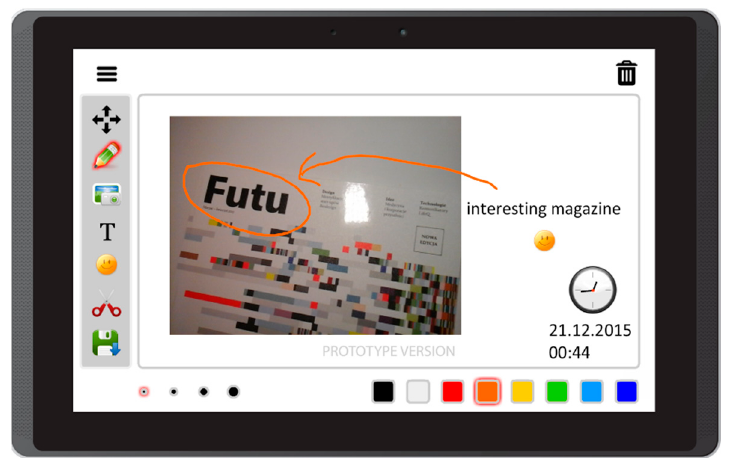
Figure 8. Adding text, emoticons, and time stamps in Aphasia Create (screenshot from an Android tablet).